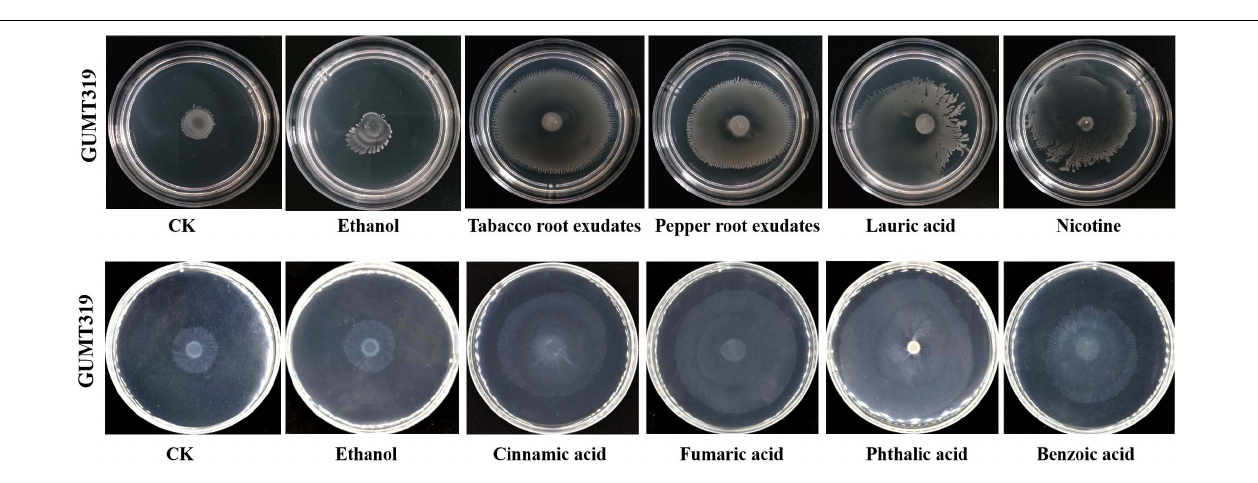
FIGURE 5 | Chemotactic response of B. velezensis GUMT319 to root